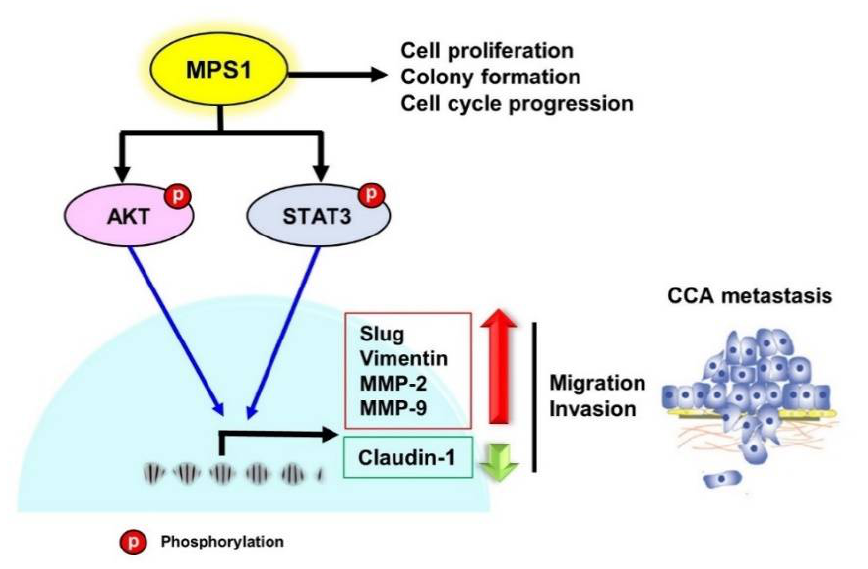
Figure 6. The proposed molecular mechanism of how MPS1 promotes the metastasis of CCA. MPS1 contributes to cell proliferation, colony formation, and alters cell cycle progression. MPS1 activates AKT and STAT3 signal transduction. These actions consequently enhance the expression of EMT markers slug, vimentin, and MMP-2/9, while modulating expression of claudin-1. These result in an increase in migration and invasion, which lead to metastasis in CCA.